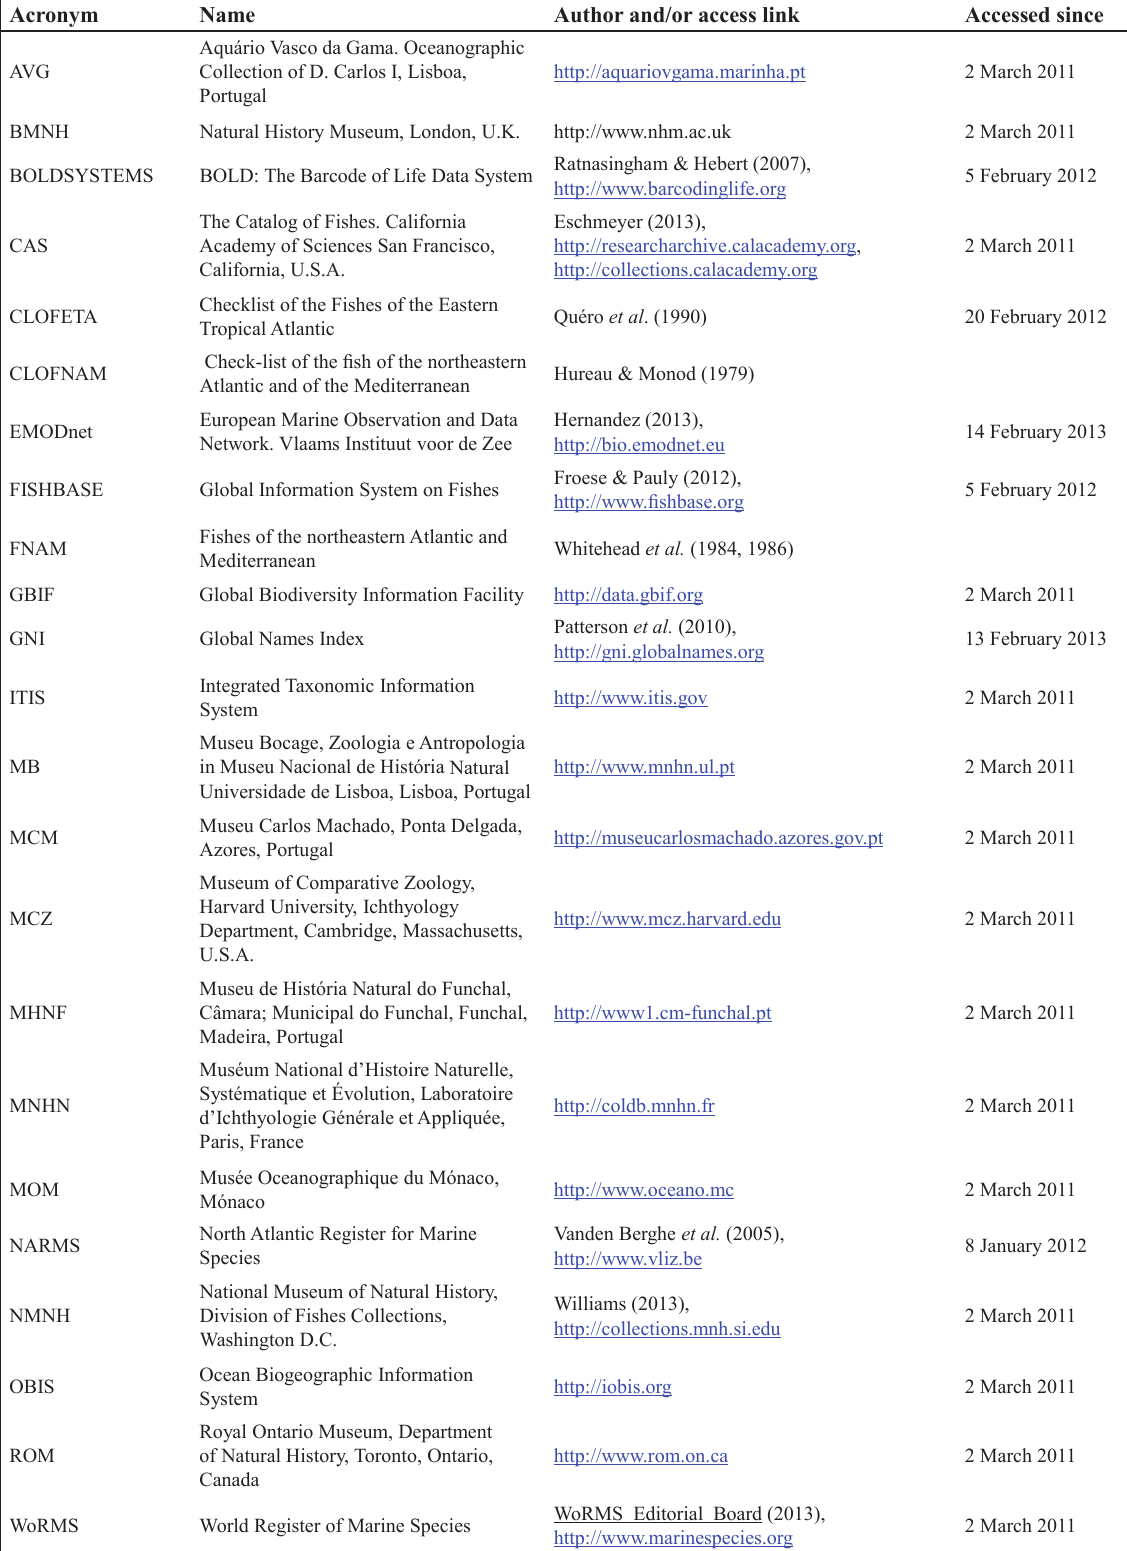
Table 2. List of electronic databases and collections databases consulted in this